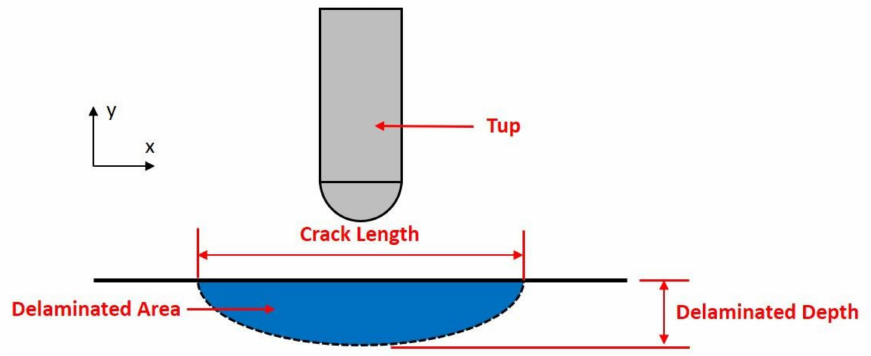
Figure 7. The schematic of the delamination morphologies.